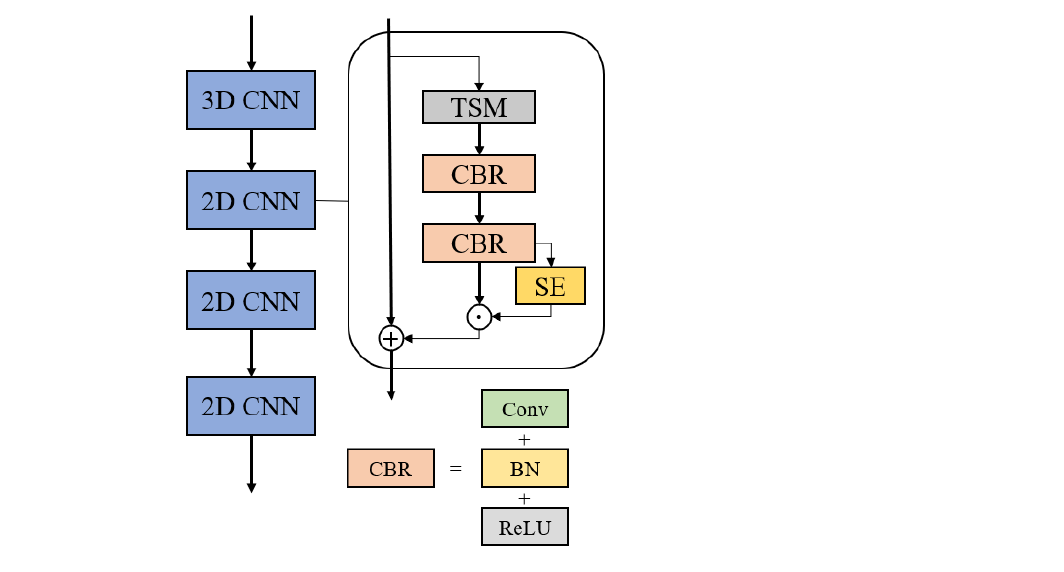
Figure 3. The implementation of the residual block in the proposed front-end. As shown in the picture above, in each residual block, the input data will first obtain the short-term time information through TSM. Then, go through the conventional convolution composed of two CBR. Finally, use the SE module to reweight the channel correlation.